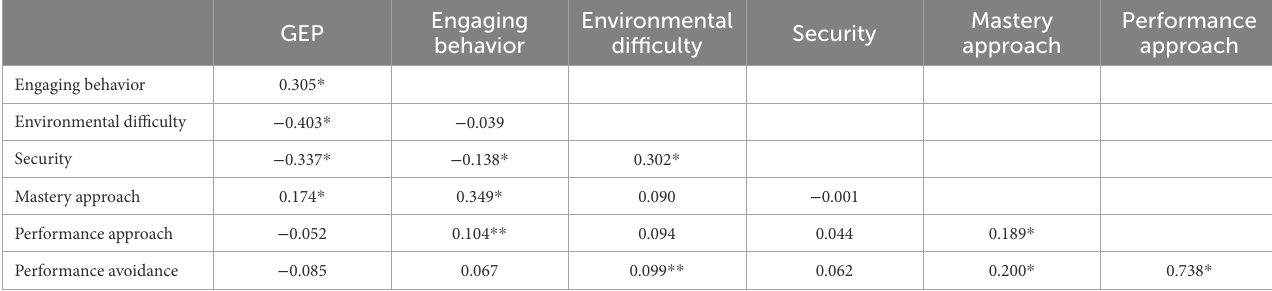
TABLE 5 Partial correlations between study variables.